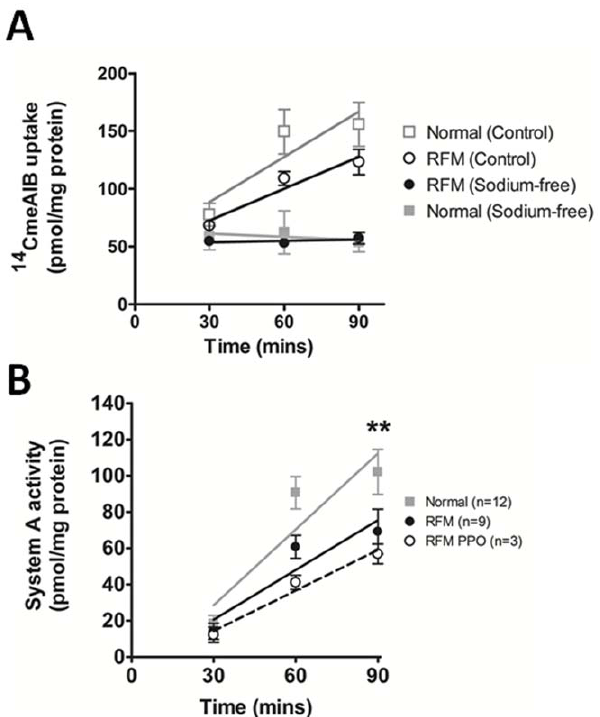
Figure 4. System A amino acid transporter activity. A) System A transporter activity is sodium-dependent, as no uptake is seen in either normal of RFM placental fragments in the absence of sodium (solid boxes). Uptake is evident in fragments incubated in the presence of sodium (hollow boxes). B) RFM placentas have significantly lower system A activity than normal pregnancies. The RFM group with poor pregnancy outcome (PPO) have the lowest system A activity. [Mean 6 SEM; **=P , 0.01, Two-way